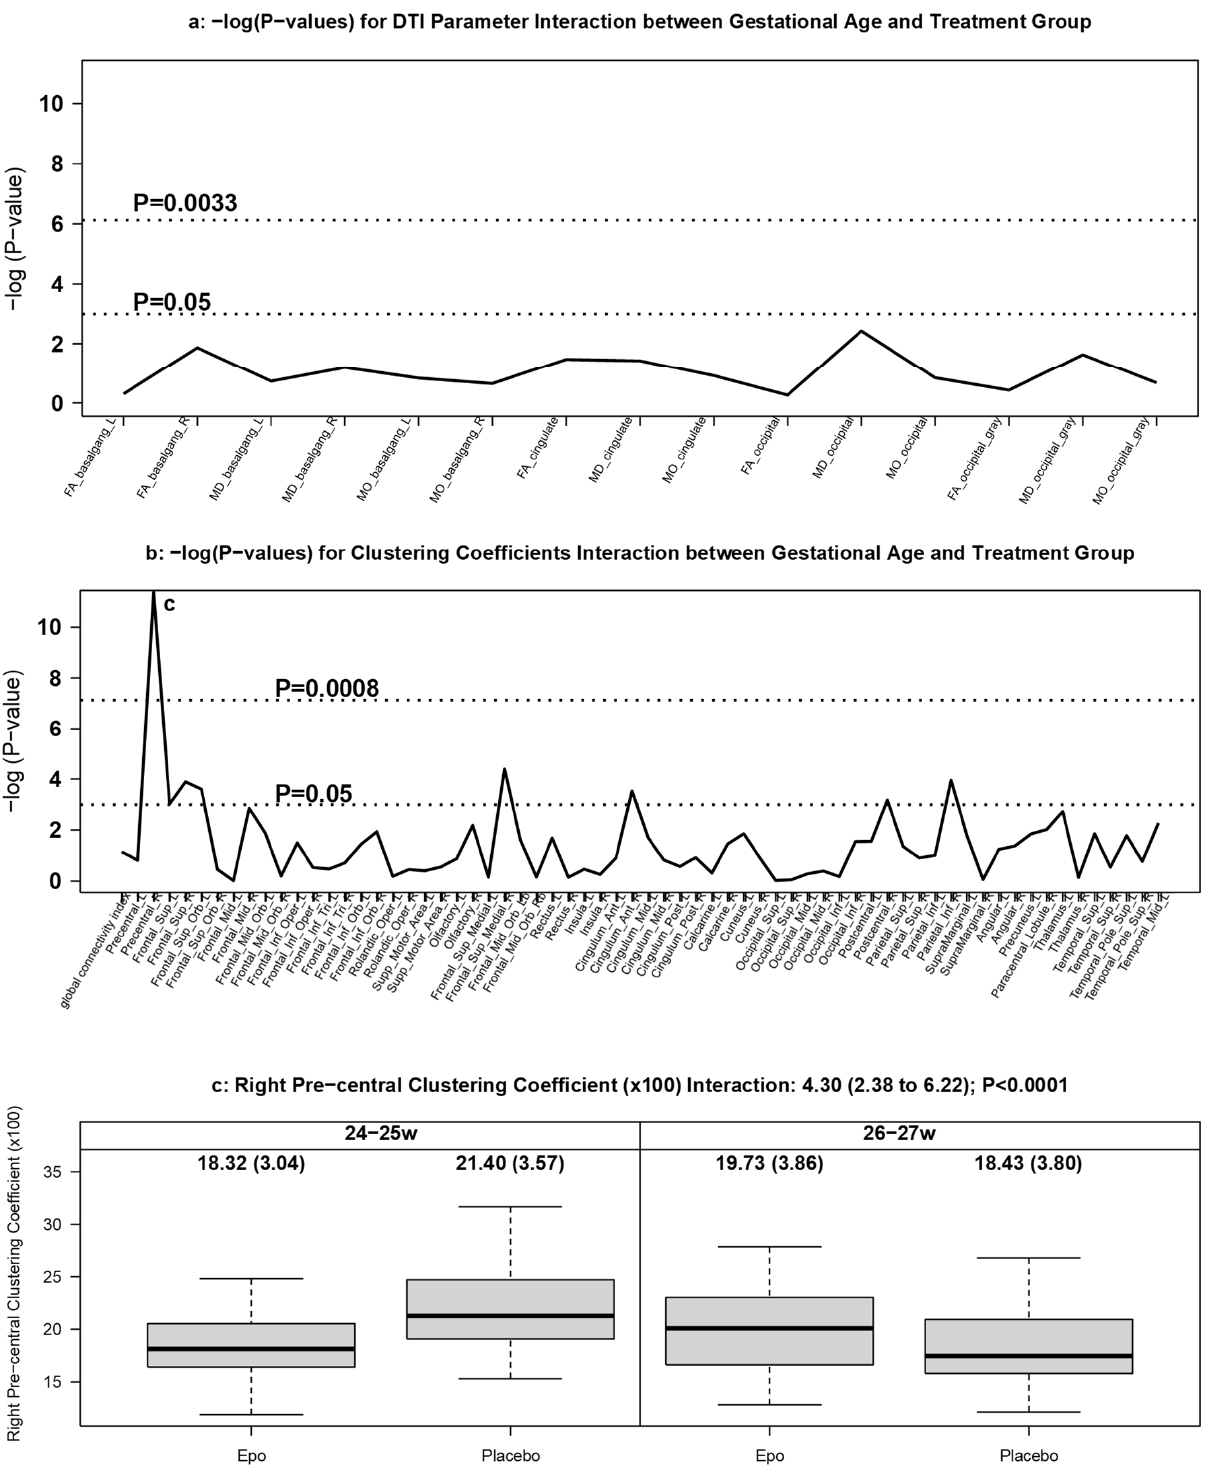
Figure 5. DTI measures by gestational age and treatment group. Manhattan plots of [GEE-based Wald test] -log ( p -values) for differences in ( a ) regional DTI diffusion values and ( b ) clustering coefficients for the interaction between GA and treatment group. Panel ( c ) displays boxplots of clustering coefficients in the right precentral region that were significantly different [GEE-based Wald test] by GA and treatment group.